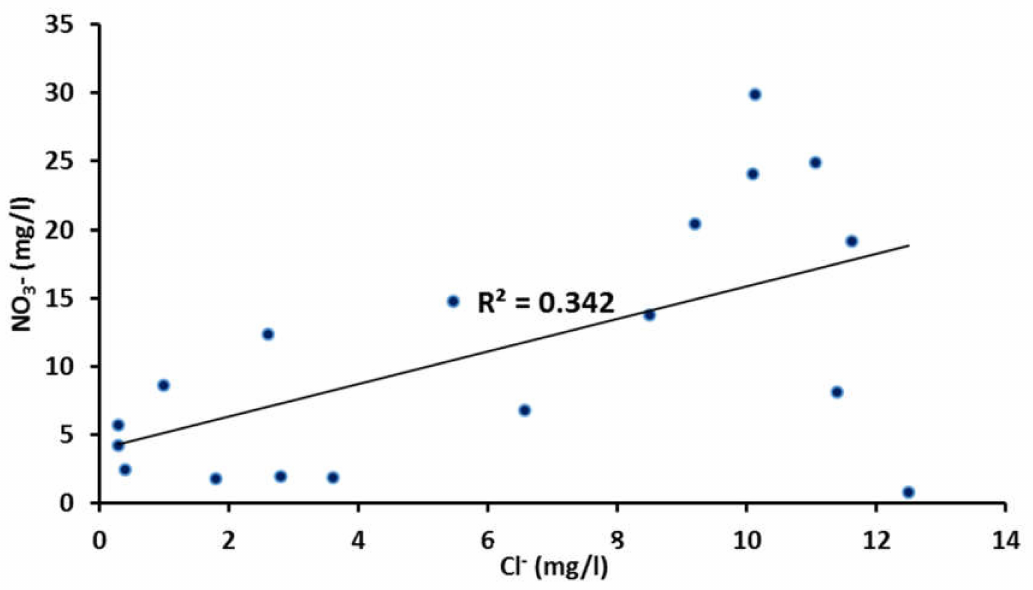
Figure 7. Chloride concentration versus nitrate concentration of the groundwater samples used for the Chloride Mass Balance (CMB) method. The small correlation coe ffi cient value (R2 = 0.34) shows the insignificant pollution e ff ect in the analyzed chloride concentration